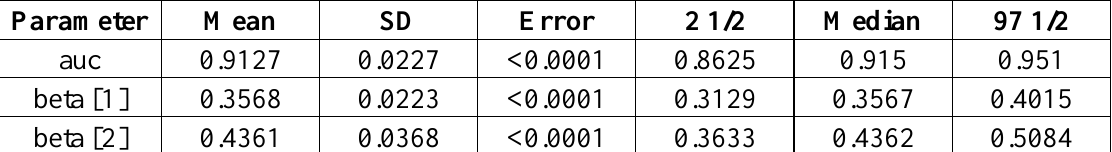
Table 30. Bayesian analysis for accuracy of the combined